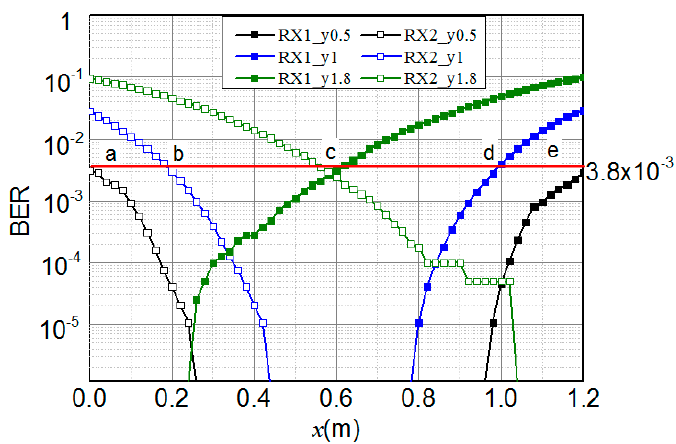
Figure 3. The BER distribution of two receivers when vertical distance is 0.5 m, 1 m and 1.8 m.